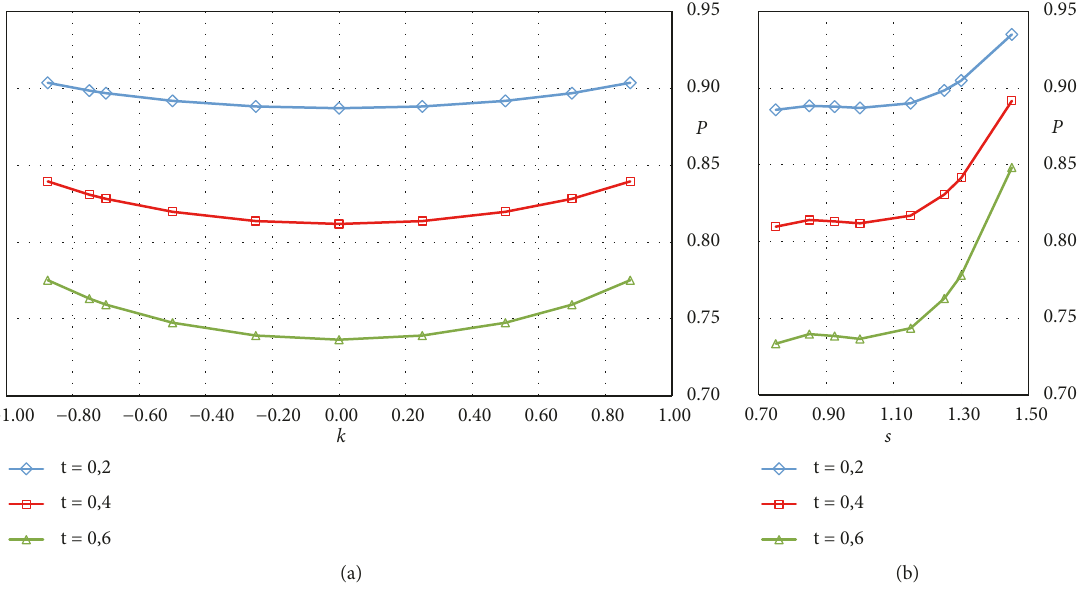
Figure 14: Trend of the porosity P , evaluated the formula (3), for solid P-cells: (a) in the case of s parameter variable ( 𝑘 = 0 ) and (b) k variable ( 𝑠 = 1 ).